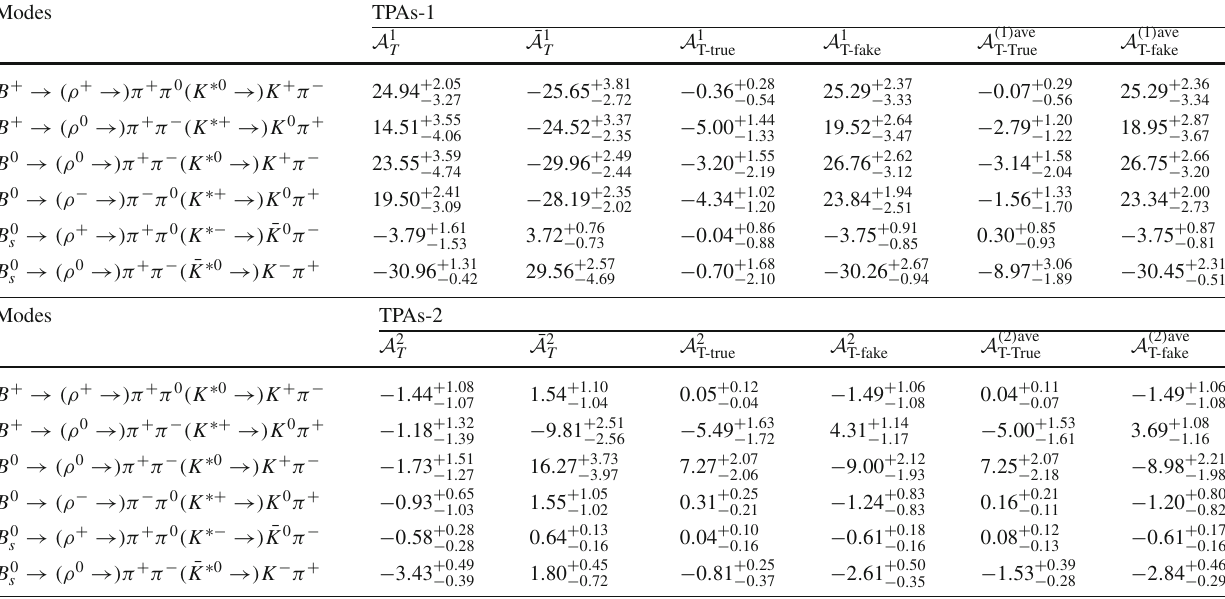
Table 9 PQCD predictions for the TPAs (%) of the four-body B ( s ) → (ρ → )ππ( K ∗ → ) K π decays. The sources of theoretical errors are same as in Table 4 but added in